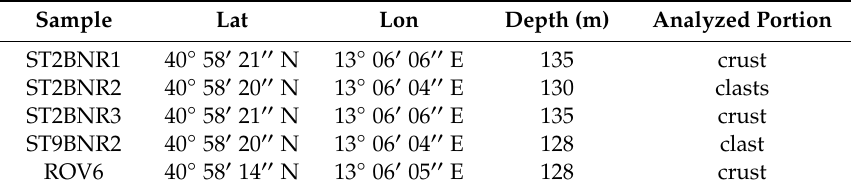
Table 1. List of grabs sampled within the Zannone Giant Pockmark